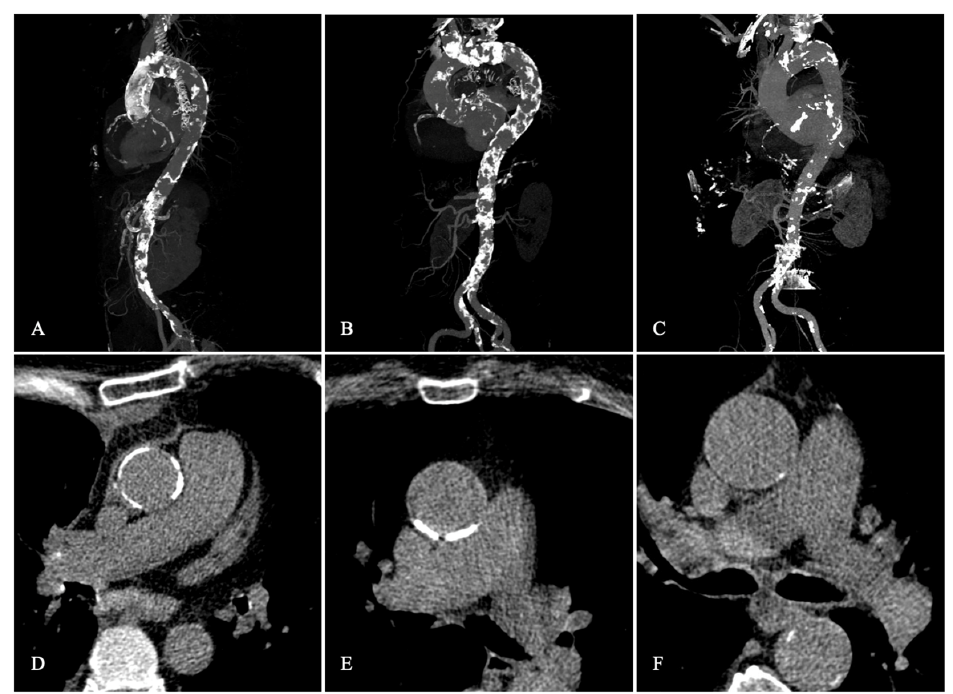
Figure 1. MDCT classification of the extent of ascending aorta atherosclerotic burden. Maximum intensity projection (MIP) of the aorto-iliac arteries demonstrating circular, near-confluent calcification of the ascending aorta ( A ); partial, non-confluent calcification ( B ); and absence of relevant atherosclerotic lesions of the ascending aorta ( C ). Axial views of the aorta at the level of the pulmonary trunk showing circular ( D ) and non-circular calcification ( E ) as well as no or minor calcification ( F ). Calcifications of the aortic arch and the descending aorta were not considered in the present analysis.